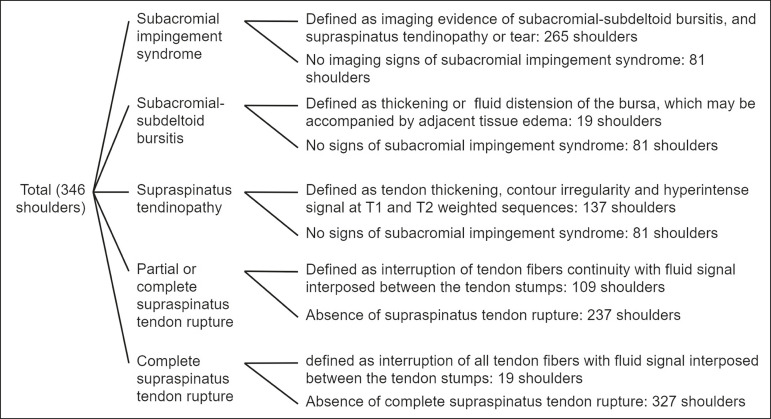
Flowchart demonstrating group division.